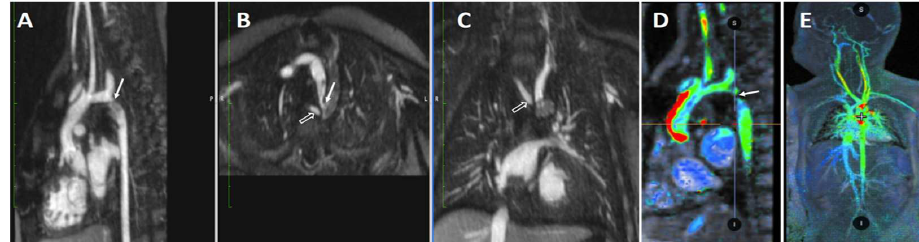
Figure 4. Coarctation of the Aorta. Panels ( A – C ): 4D FE-MRA (MUSIC) in a neonate with juxtaductal coarctation of the aorta (solid arrows) and hypoplastic transverse aortic arch. Additionally, present is an aberrant right subclavian artery (open arrow). Panels ( D , E ): Ferumoxytol-enhanced 4D flow in a different patient with coarctation showing anatomic narrowing of the aortic isthmus (solid arrow) with red flow (plus sign) indicating acceleration of blood flow across the area of stenosis.